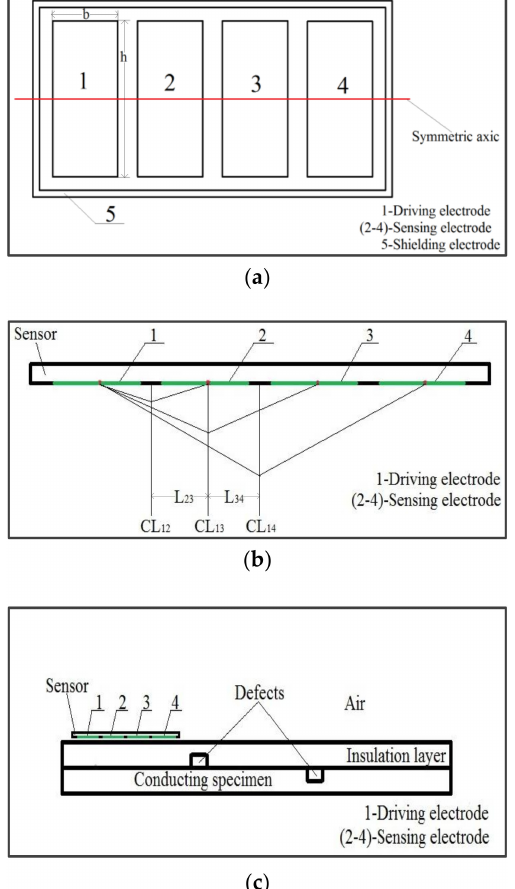
Figure 3. ( a ) the front view of the multi-electrode sensor, ( b ) the cross-section of the multi-electrode sensor and ( c ) the multi-electrode sensor inspecting the conducting specimen covered by the insulation